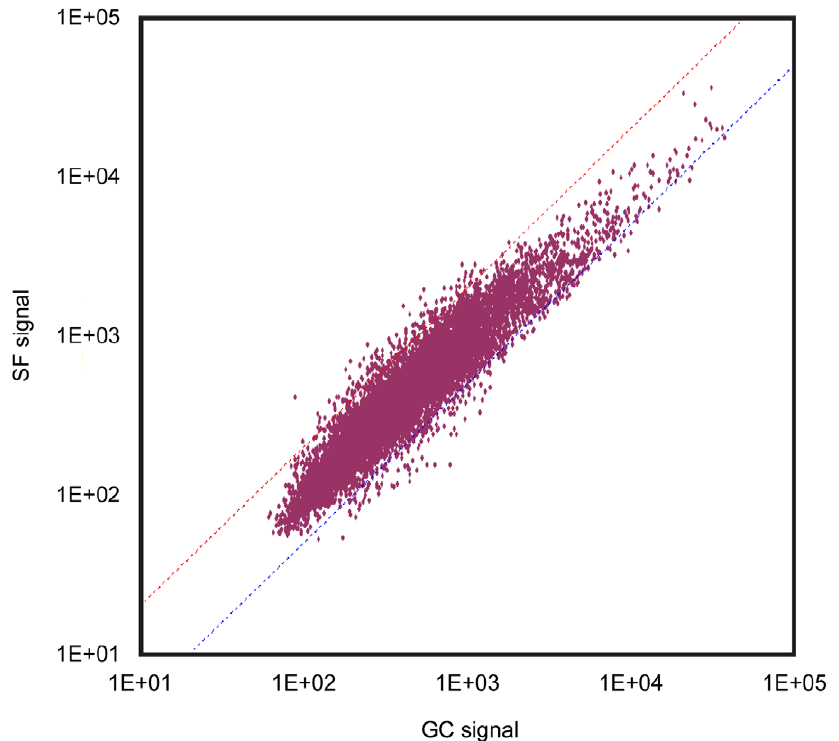
Figure 5. Scatter plots showing the relationship of gene expression between group GC and SF. The dots above and below the dotted slanted lines show the genes in group SF up- and down-regulated, more than 2 folds and/or less than half, vs. those in group GC, according to SAM analysis. See Figure 1 for the abbreviations.